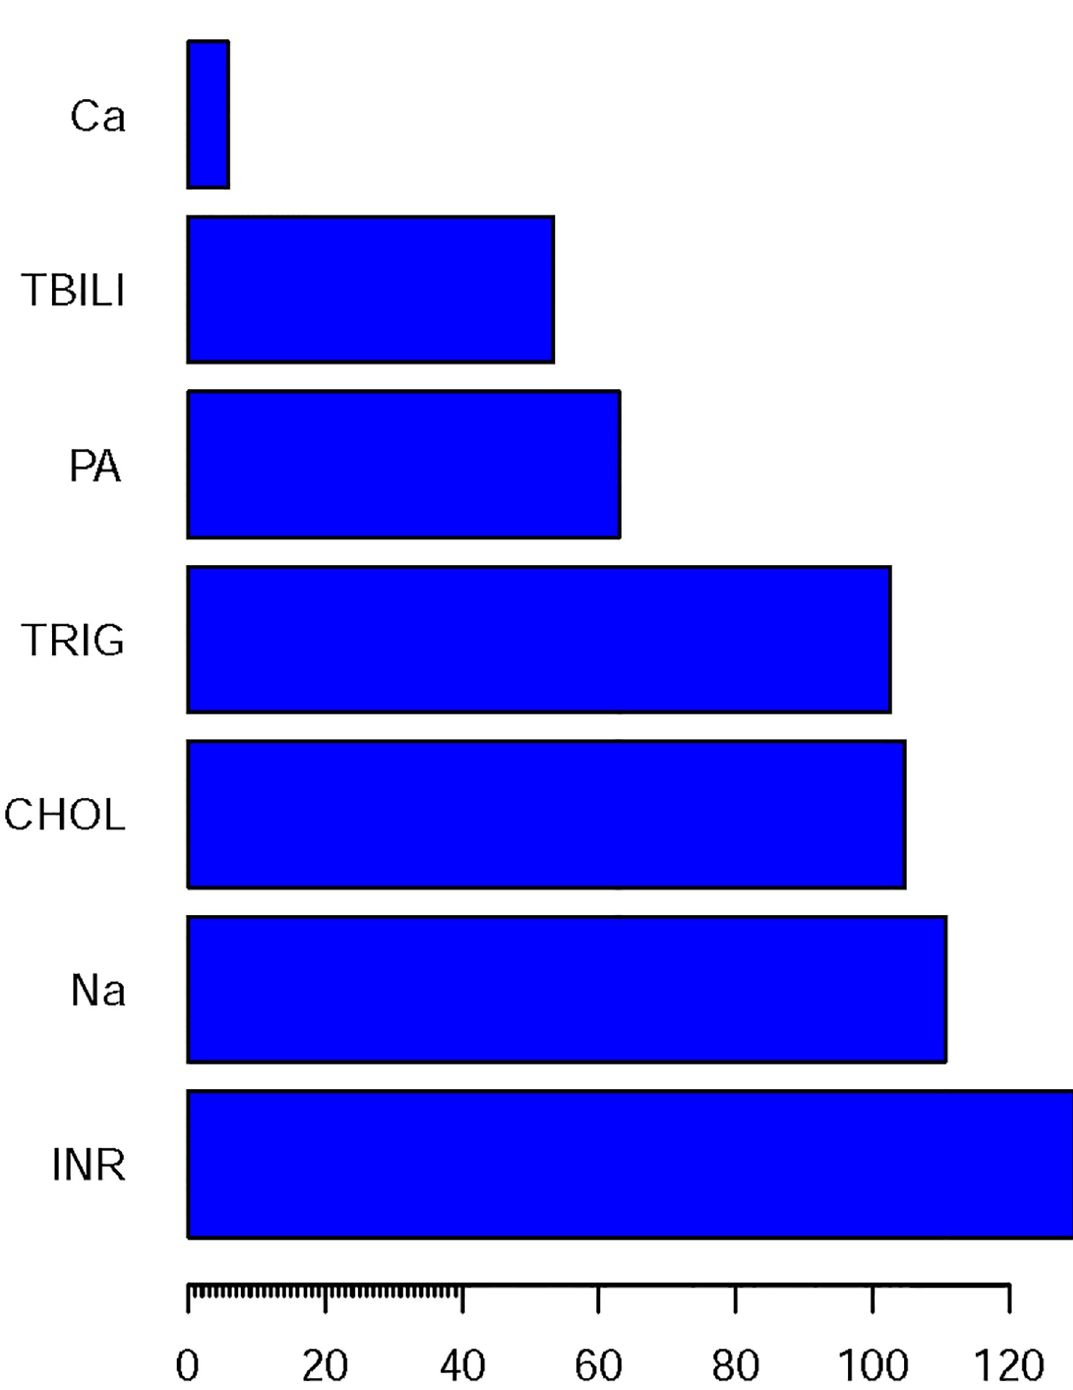
Fig 2. Importance of each predictor of the CART models. Predictors with a smaller Gini value contribute more information to prediction models than ones with higher Gini